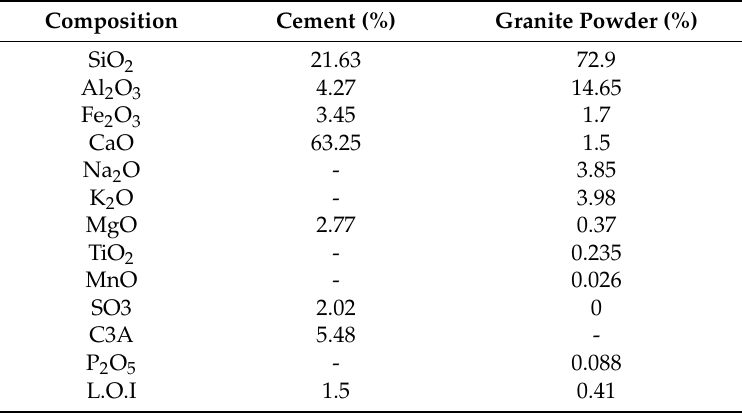
Table 1. Chemical characteristics of cement and waste granite powder (WGP).